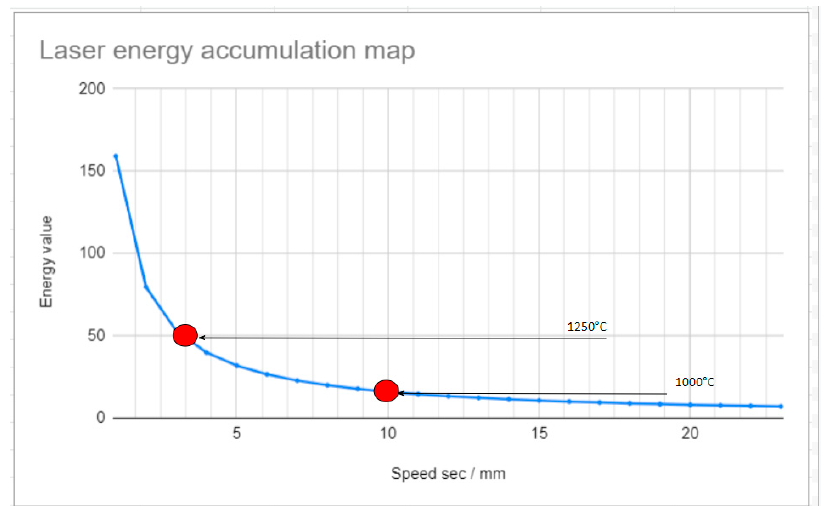
Figure 5. Comparative chart of ceramic melting point, laser-firing energy, and kiln-firing temperature (20 W, laser).